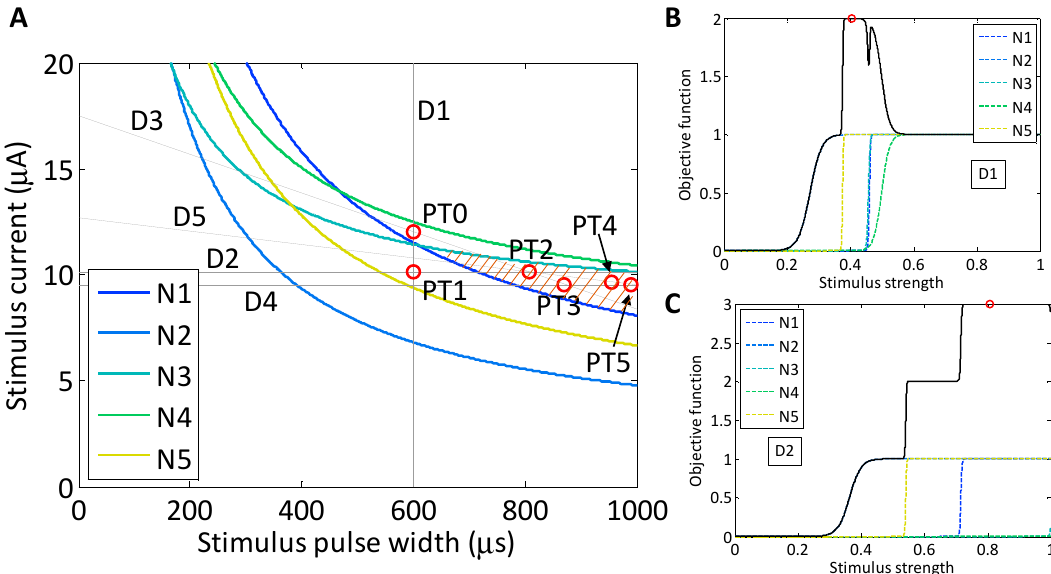
Figure 9. ( A ) The strength–duration curves from a fit to Equation (2) with P = 0.5, are plotted for five neurons using the experimental data collected during the CL search routine. The simulated target population of neurons was chosen, including N1, N2 and N5, and an objective function was created to promote the activation of the target neurons while penalizing the activation of the off-target neurons, Equation (7). The five searches resulting from a simulated search routine are marked with faint lines, and the objective function maxima are labeled and highlighted with open circles; ( B , C ) the objective function along each search direction is plotted with a solid black line. The maximum of the function is found at the open circles in each plot, which correspond to the various search directions in Powell’s method.